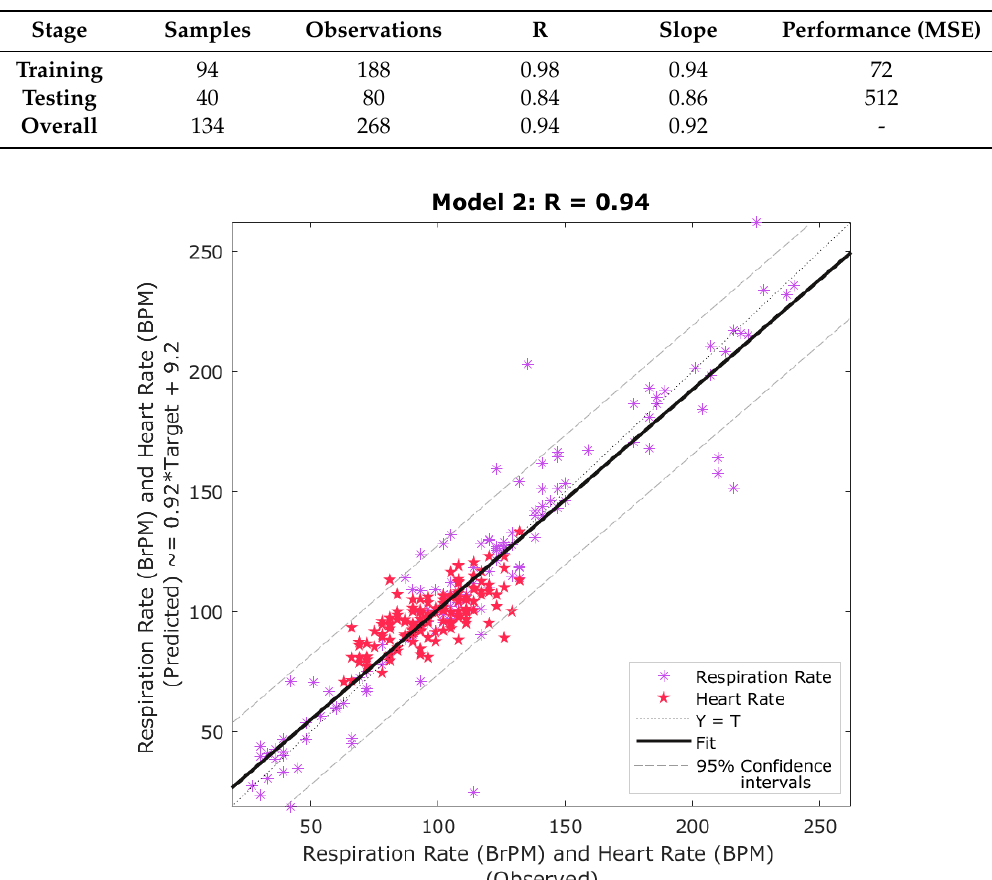
Figure 6. Artificial neural network overall fitting model showing the correlation coefficient (R), observed (x-axis), and predicted (y-axis) respiration rate and heart rate values. Abbreviations: BrPM: breaths per minute; BPM: beats per minute; T: Targets.